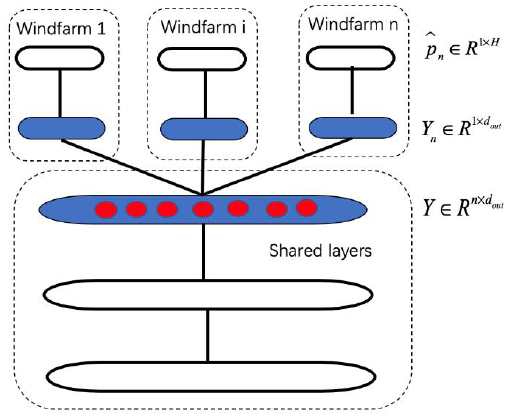
Figure 4. Hard parameter sharing for multi-task learning.